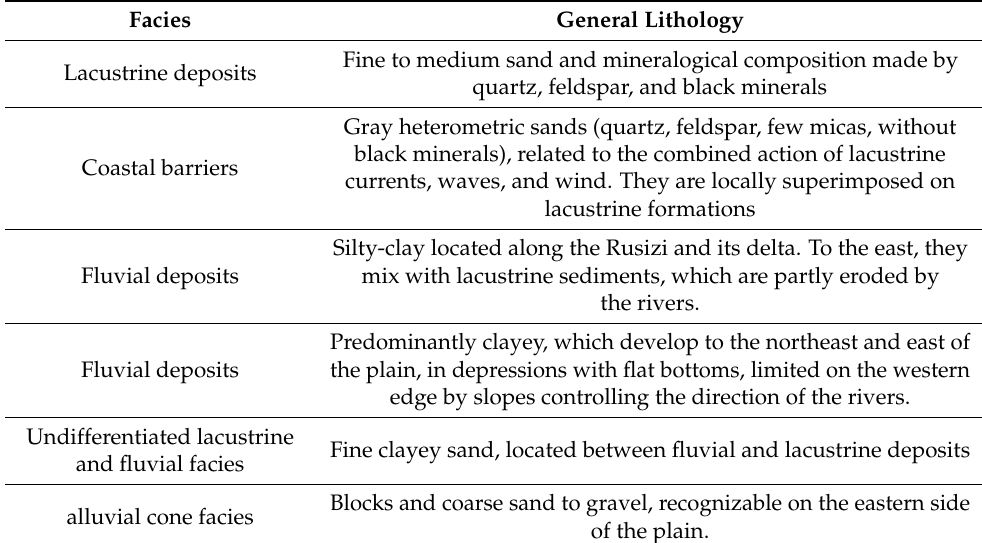
Table 2. Sedimentological description of the Lower Rusizi